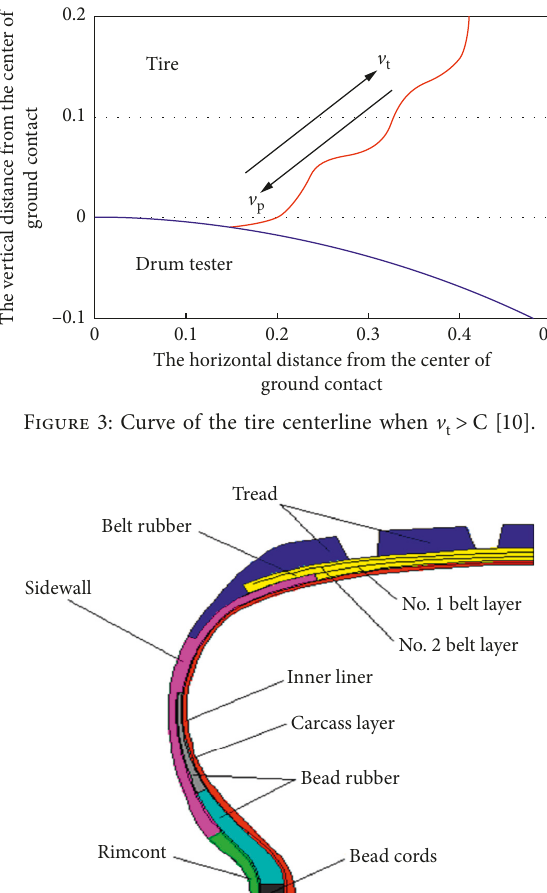
Figure 4: Diagram of the tire’s sectional